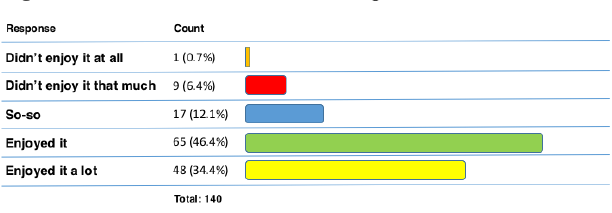
Fig. 10 . Overall satisfaction with the